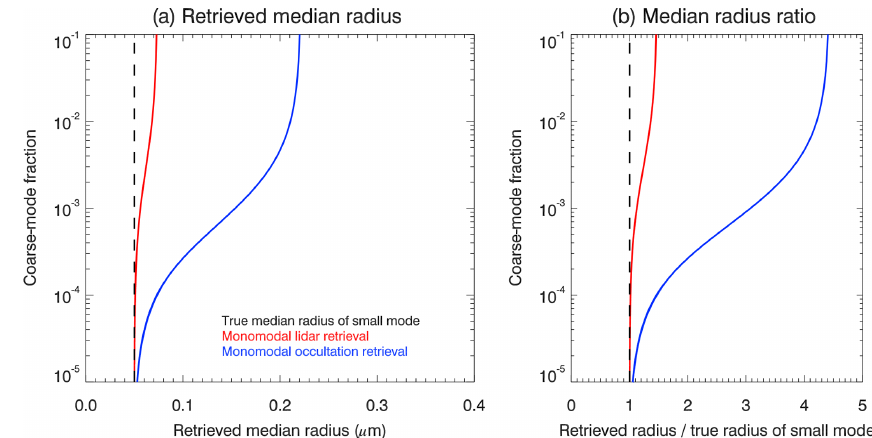
Figure 10. Similar to Fig. 3 but for a different set of parameters of the bimodal particle size distribution ( r 1 = 50nm, S 1 = 1 . 4, r 2 = 300nm, S 2 = 1 . 2; i.e., case 2 in Table 1).